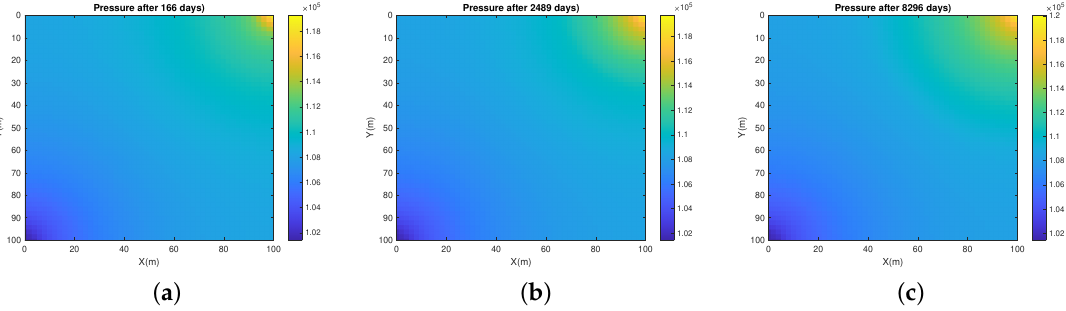
Figure 1. Pressure at different time for Example 1: ( a ) Pressure (after 166 days). ( b ) Pressure (after 2489 days). ( c ) Pressure (after 8296